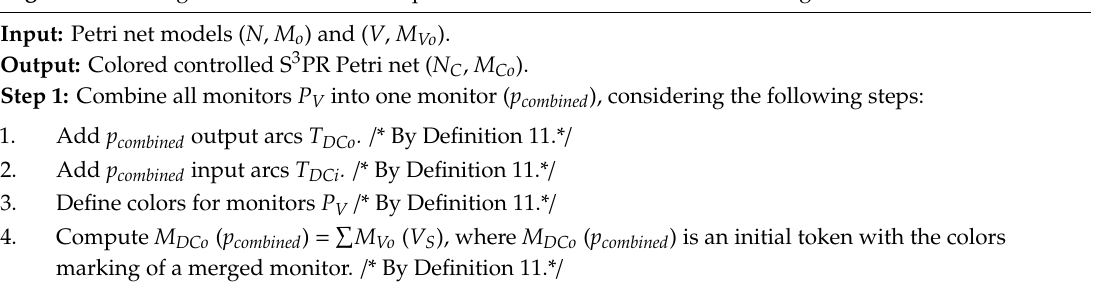
Algorithm 2: Integrated Strict Minimal Siphon And Colored Petri Nets-Based